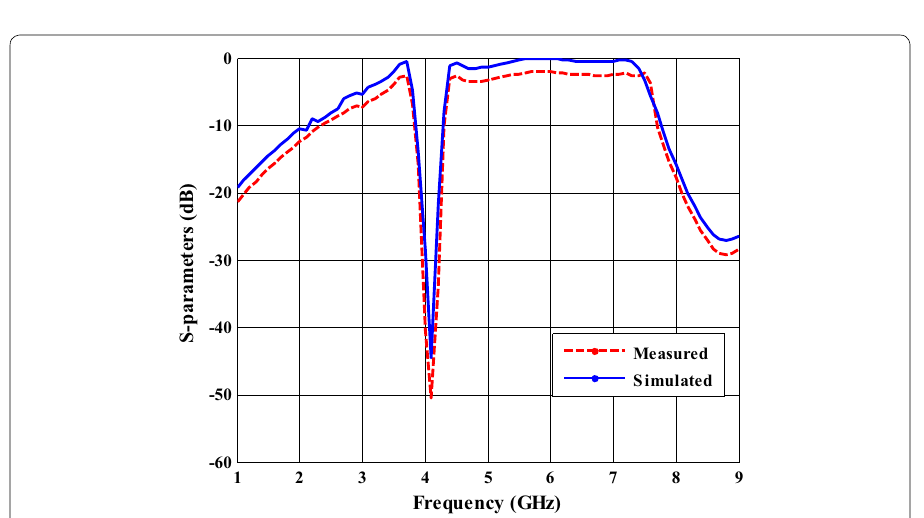
Fig. 10 Simulated and measured S 21 of